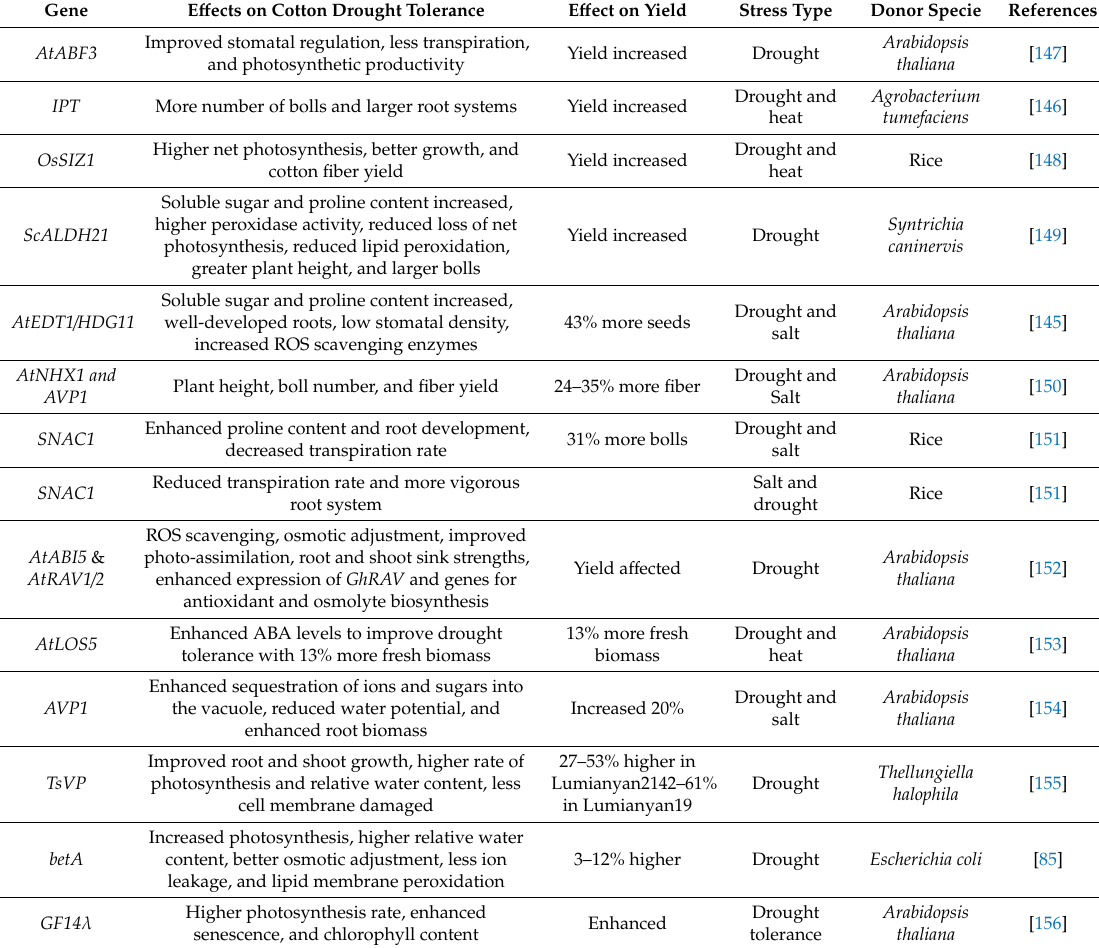
Table 4. Transgenes overexpressed in cotton for drought